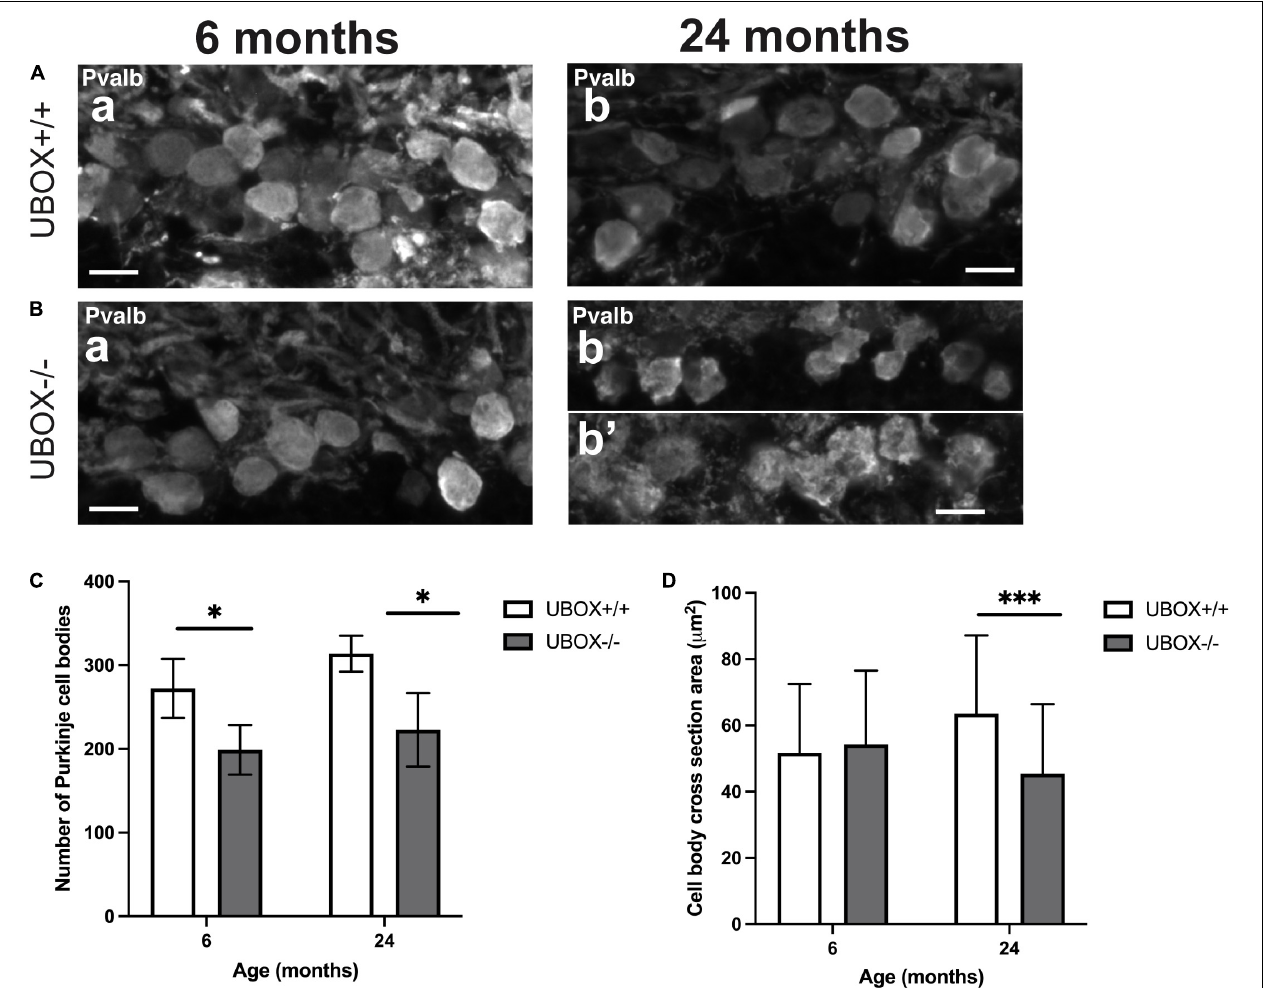
FIGURE 7 | The number and size of Purkinje cell bodies are progressively reduced in U-box − / − fish. Fluorescent immunohistochemistry on 8 µ m sagittal cryosections on wild-type (A) and mutant (B) at 6 (a) and 24 (b,b’) months fish using Parvalbumin as a marker for Purkinje cells. (C,D) present quantification results for the average number of Purkinje cell bodies (C) and average cell body cross-section area (D) at the two time-points as means ± standard deviations. Statistically significant differences are shown by asterisks ( ∗ p < 0.05 and ∗∗∗ p < 0.001 Student’s t -test). Scale bars in (A,B) : 10 µ